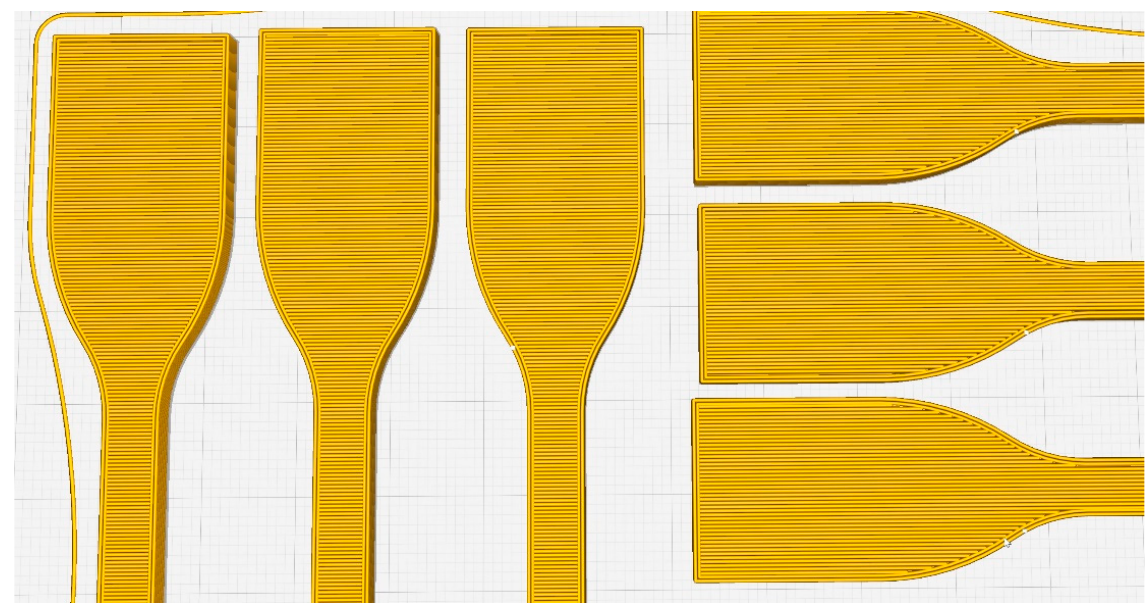
Figure 2. The orientation of the test specimens (vertical and horizontal).